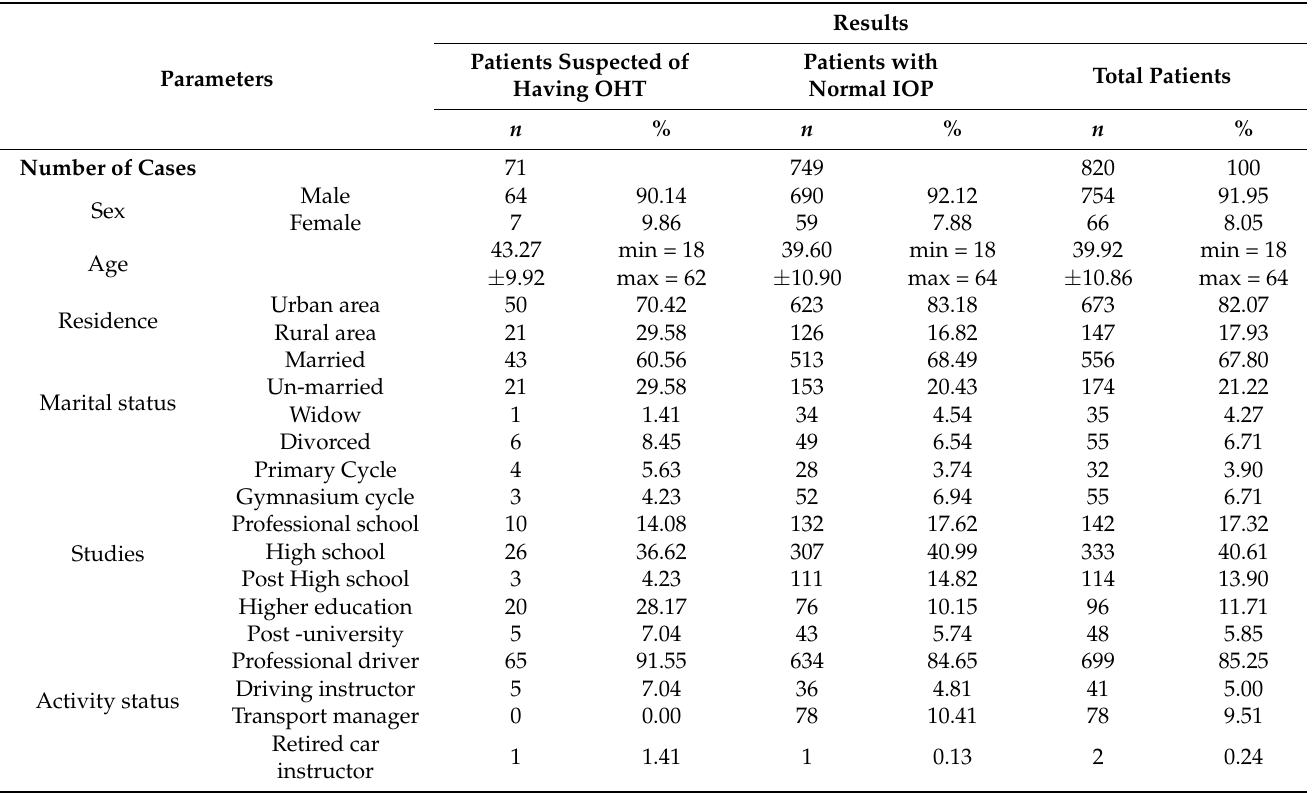
Table 2. Distribution of demographic indicators of